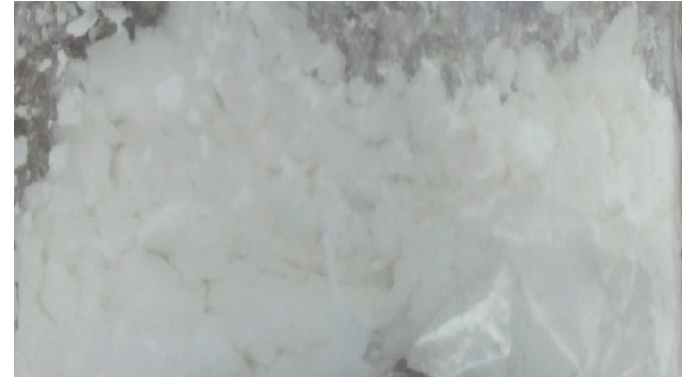
Figure 1. Extracted starch. Table 2. Physical and chemical properties of corn and rice starch.